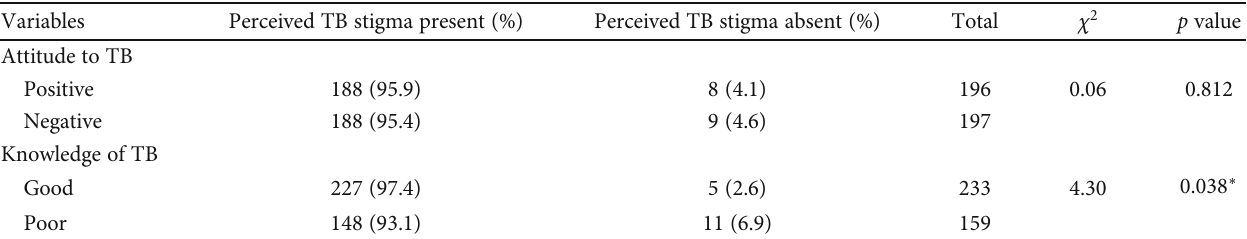
(b) Association between respondent knowledge and attitude and perceived TB-associated stigma in urban